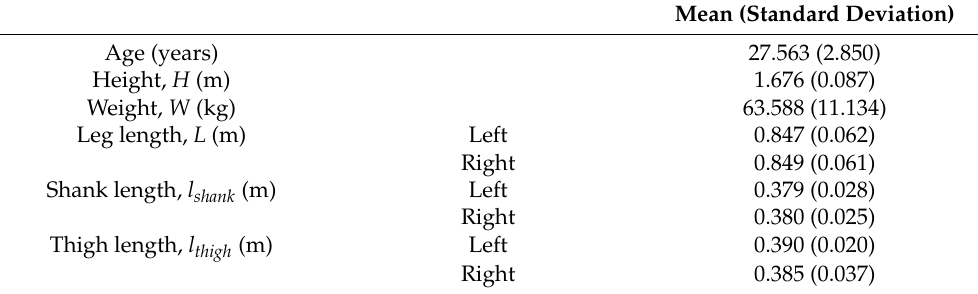
Table 1. Summary of subject profiles.